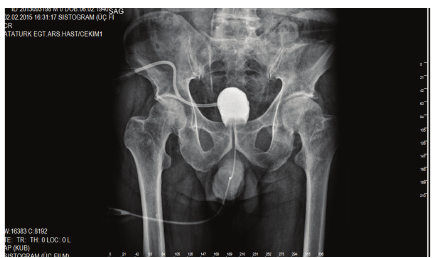
Figure 10: It was seen that there was no fistula any more between the urethra and rectum in postoperative cystography 3 months after